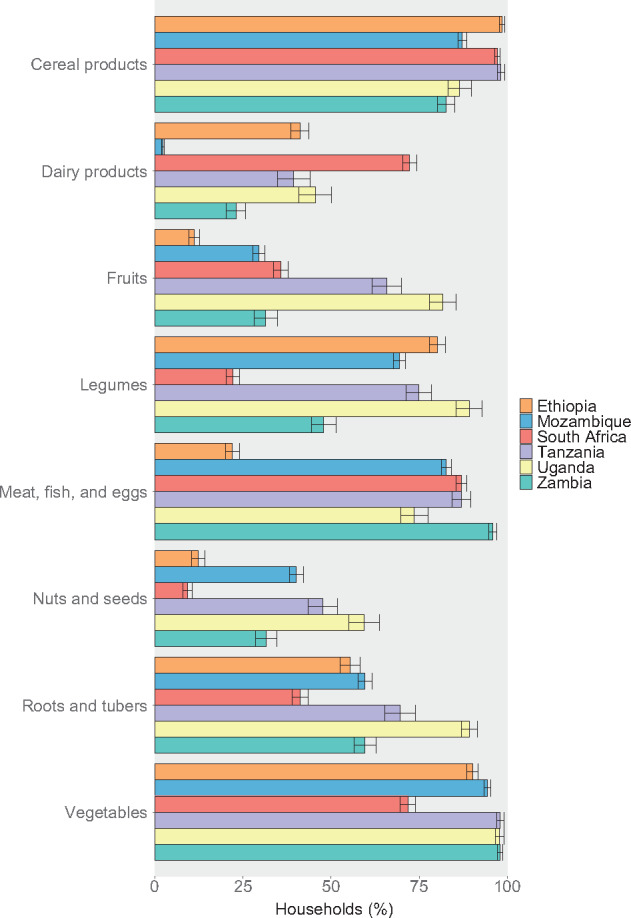

Household consumption of key food groups. Other food groups, including sugar and other sweets; oils and other fats; salt, other spices, and condiments; beverages; and foods eaten outside of the home were omitted for brevity. Surveys covered household consumption over the past week, except for South Africa and Zambia, which covered the past 2 weeks. For all countries, only households with children of complementary feeding age are shown, yielding sample sizes of 5808 households in Ethiopia, 9441 in Mozambique, 3303 in South Africa, 1062 in Tanzania, 728 in Uganda, and 2054 in Zambia. Error bars represent 95%CIs.